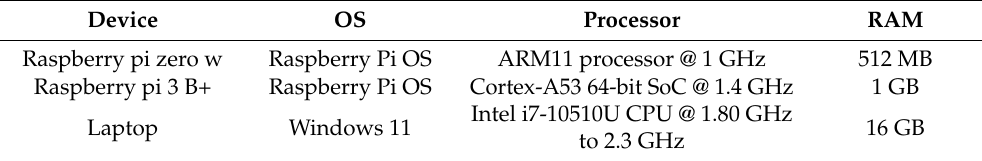
Table 1. Device specifications.